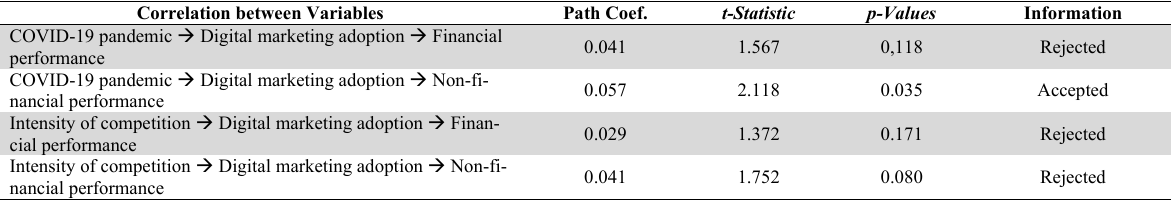
Indirect Effects Correlation between